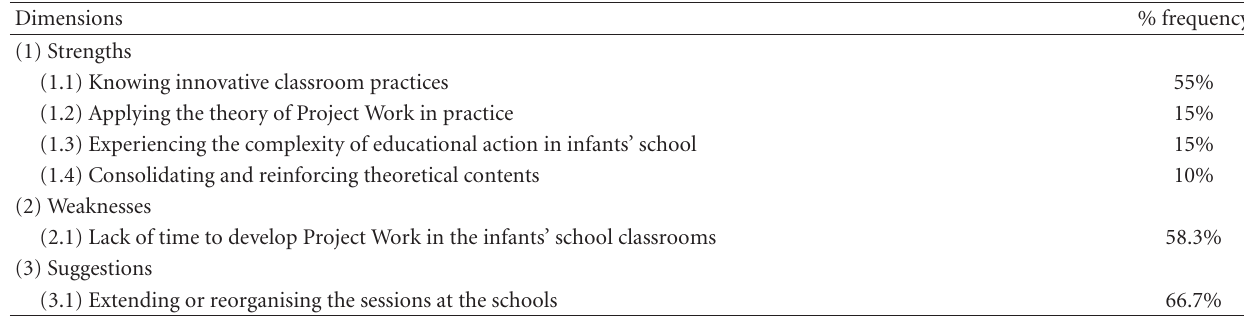
Table 2: Categorisation of the open-ended questions on the